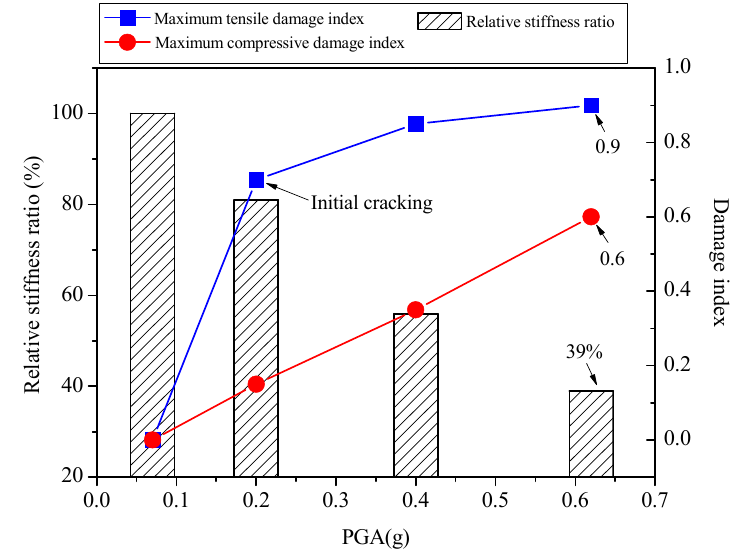
Figure 13. Relative stiffness ratios and maximum damage indexes under different hazard levels.